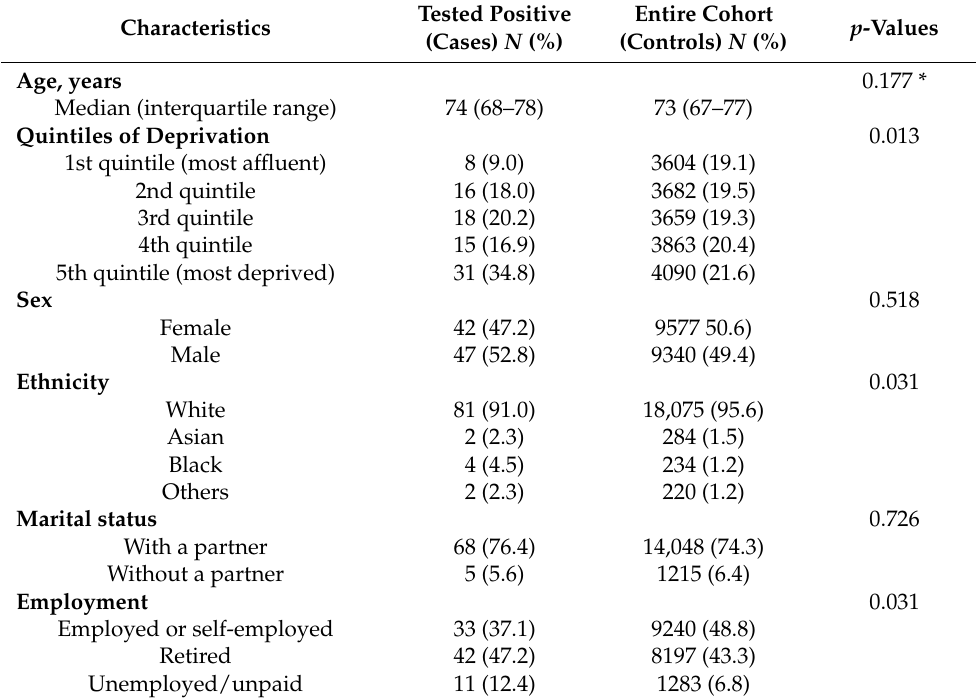
Table 1. Case-Cohort Control Study Socioeconomic Characteristics, Smoking Status BMI, and